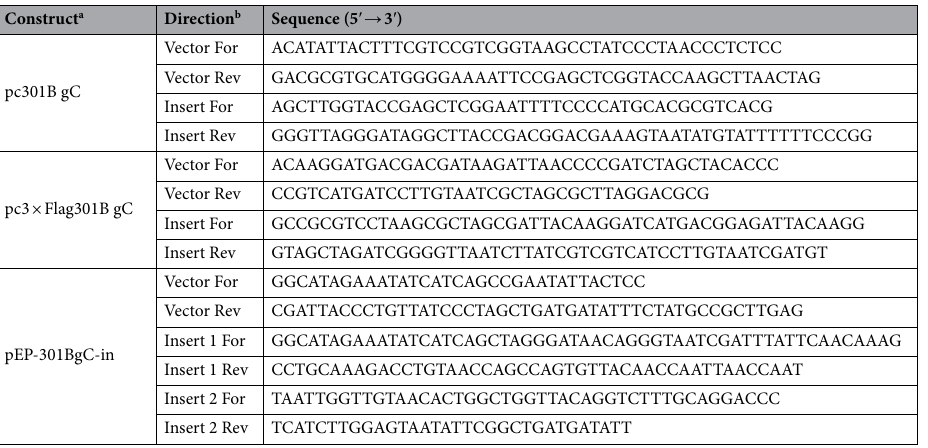
Table 2. Primers used for cloning and generation of shuttle vectors using Gibson assembly cloning. a Construct generated with the set of primers. b Directionality of the primer and product produced for Gibson assembly